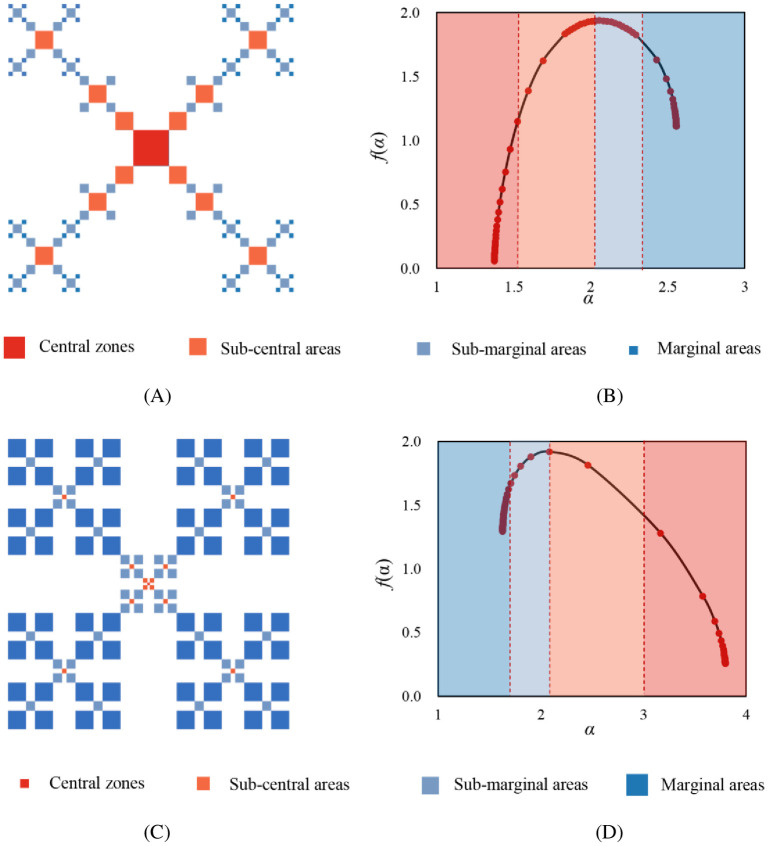
The singularity spectrums of two different multifractal growth modes: Spatial concentration and deconcentration.(A) Spatial aggregation mode; (B) Singularity spectrum for spatial aggregation; (C) Spatial diffusion mode; (D) Singularity spectrum for spatial diffusion. Note: The squares with larger size represent network intensive areas, while the smaller squares represent network sparser areas. The local parameter f(α) curve stands for the local fractal dimension of the sets of units with the singularity exponent α.